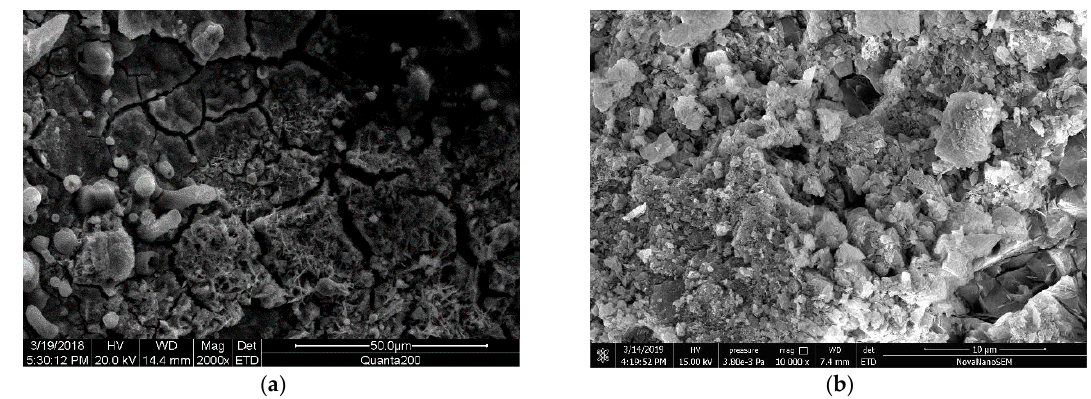
Figure 8. SEM images of rust layer in seawater and sea-sand concrete under continuous immersion; ( a ) Initial rust layer morphology of A1, ( b ) Later rust layer morphology of A1.